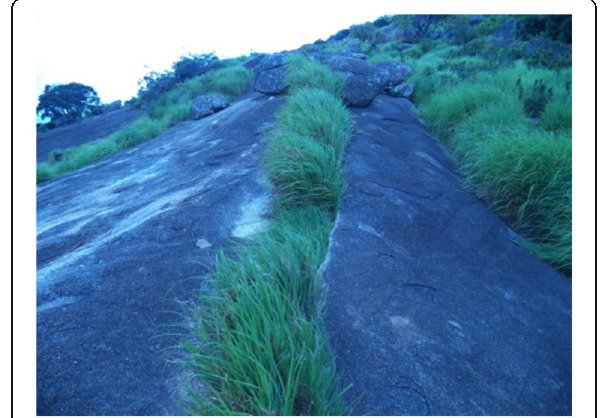
Fig. 4 Field photograph showing a major (NW-SE) fracture on the granite hill outcrop southwest of Kwoi Town and south of the displaced outcrop due to